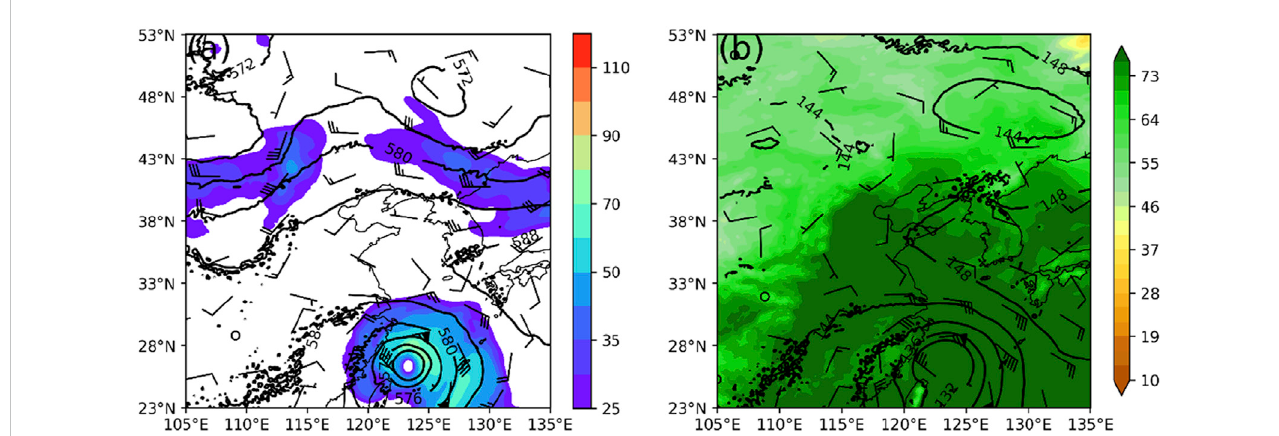
FIGURE 4 TheNCEPFNLanalysisat00 UTCon9August2019. (A) The500 hPageopotentialheight(contours;gpm),windbarbs(afullbarbis5 m/s),andhorizontal wind speed (shading; m/s). (B) 850 hPa geopotential height (contours; gpm), wind barbs (a full barb is 5 m/s), and relative humidity (shading; %).